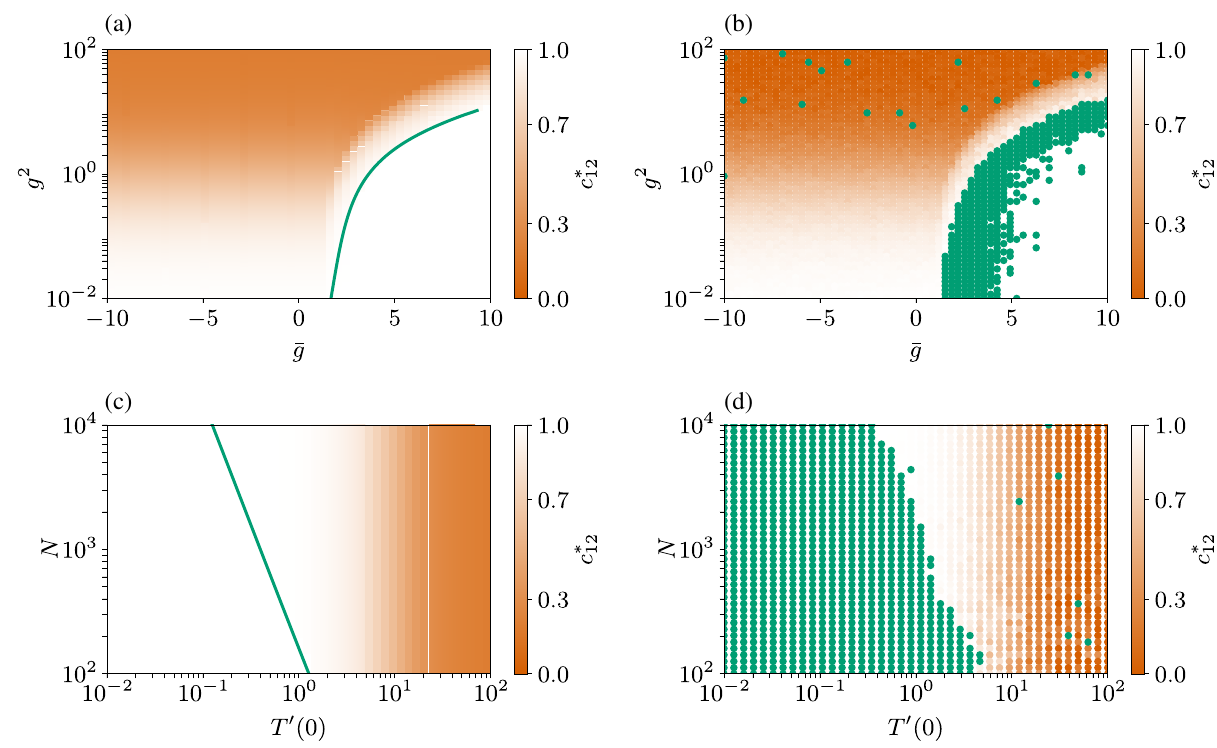
FIG. 4. Chaos transition and residual correlation in theory (a),(c) and simulations (b),(d). (a) Theoretical prediction of chaos transition [green line, Eq. (15)] and residual correlation coefficient between replicas [dark orange shading, c (cid:3) 12 ¼ 1 − Q ð 0 Þ − 1 ϵ (cid:3) and Eq. (13)] for varying mean ¯ g and variance g 2 of the connectivity. Other parameters are N ¼ 5000 , T ¼ tanh, τ ¼ 10 ms. (b) As in (a), but each pixel is colored dark orange (chaotic) or green (stable) according to a network simulation. Two identical networks are evolved with identical 2500 ms the correlation between the state vectors is random numbers, only one being perturbed by flipping four spins, and after T sim ¼ computed. The few scattered green dots in the chaotic regime are algorithmic artifacts where the perturbation is unsuccessful; see the Appendix 11 for the perturbation method. (c) Theoretical prediction for varying network size N and slope T 0 ð 0 Þ of the activation function T ð h Þ ¼ tanh ð T 0 ð 0 Þ h Þ . Other parameters are ¯ g ¼ 0 , g 2 ¼ 0 . 01 , and τ ¼ 10 ms. (d) As in (c) but from network simulations, with procedure as described for